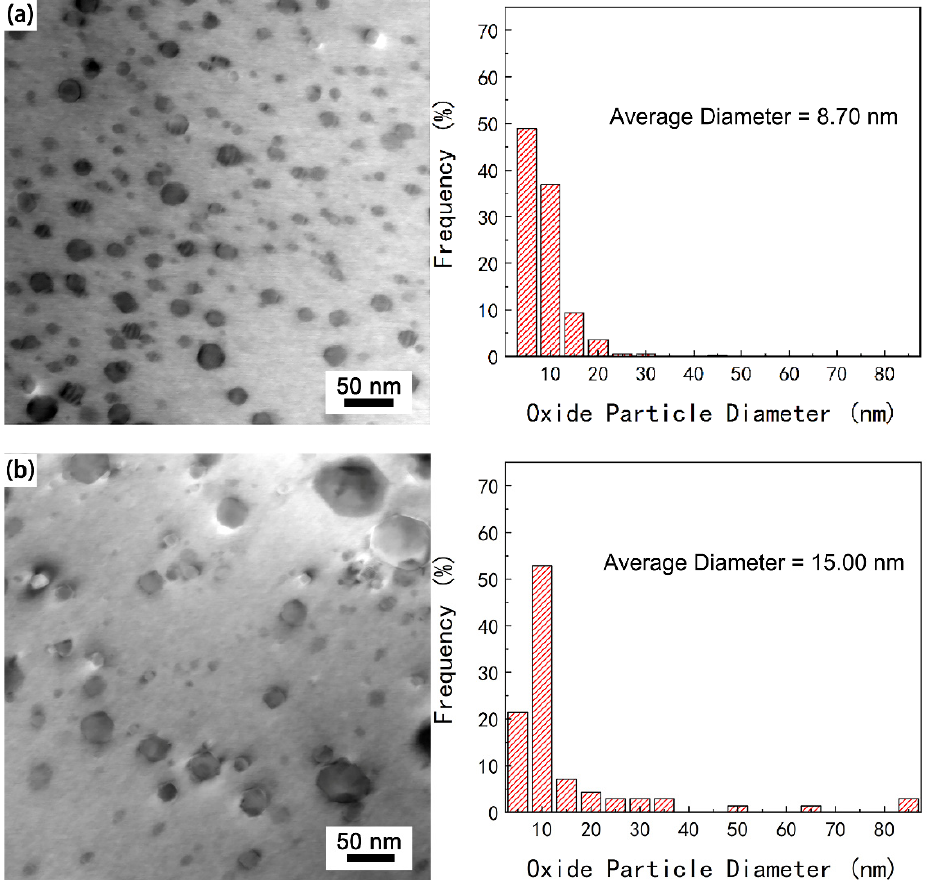
Figure 8. TEM image and size distribution of secondary phase oxides in ( a ) S1 and ( b ) S2 after oxidation in air at 1000 °C for 200 h.